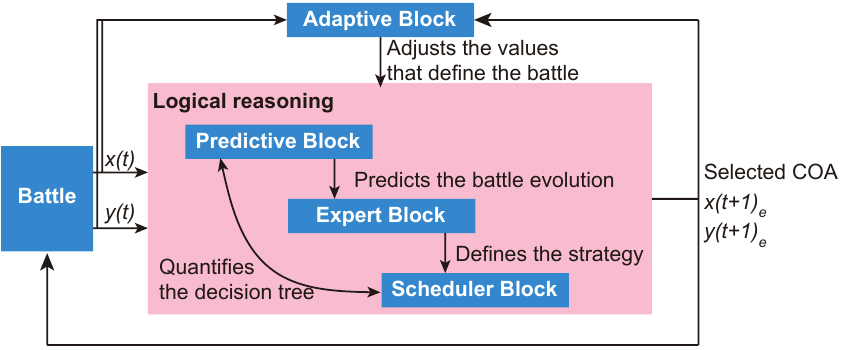
Figure 1. Architectural design of our framework. Each block represents the mechanics of military thinking, thus (i) assessing the events of the battle that will define the strategy to be followed and selecting the COA to accomplish the mission, (ii) identifying the resources that will be necessary to carry it out, and finally (iii) adapting to the